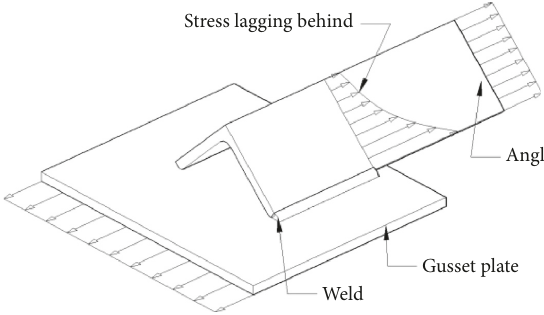
Figure 1: Shear lag in single